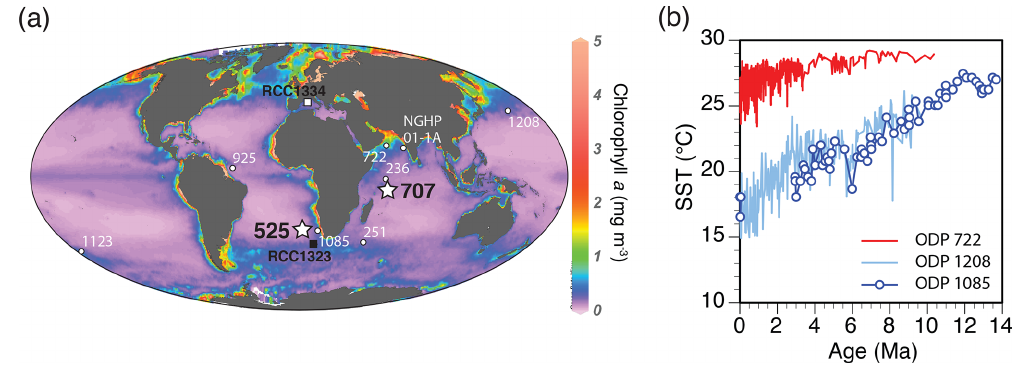
Figure 2. (a) Locations of DSDP Site 525 and ODP Site 707 (stars) and other coring sites (open circles) under discussion, as well as isolation sites of RCC cultures (squares) analyzed in Šupraha et al. (2015). Map as Mollweide projection with an overlay of annual average Chlorophyll a concentrations (data obtained from the Ocean Color database, NASA, 2018, http://oceancolor.gsfc.nasa.gov/, last access: 2 August 2019) was created using the Ocean Data View 4 software (Schlitzer, 2018). (b) Long-term trends in sea surface temperature (SST) at selected temperate and tropical sites (data from Herbert et al.,